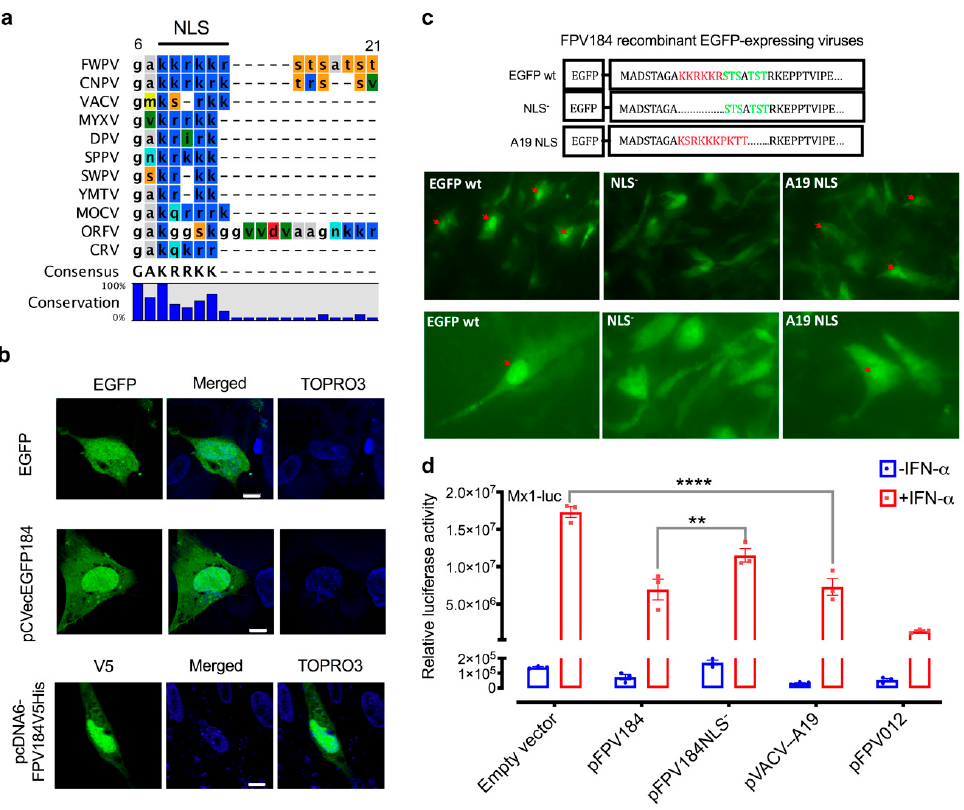
Figure 5. FPV184 NLS is functional, and nuclear localisation is needed for the protein’s immunomodulatory ability. ( a ) Multiple amino acid sequence alignments of FPV184